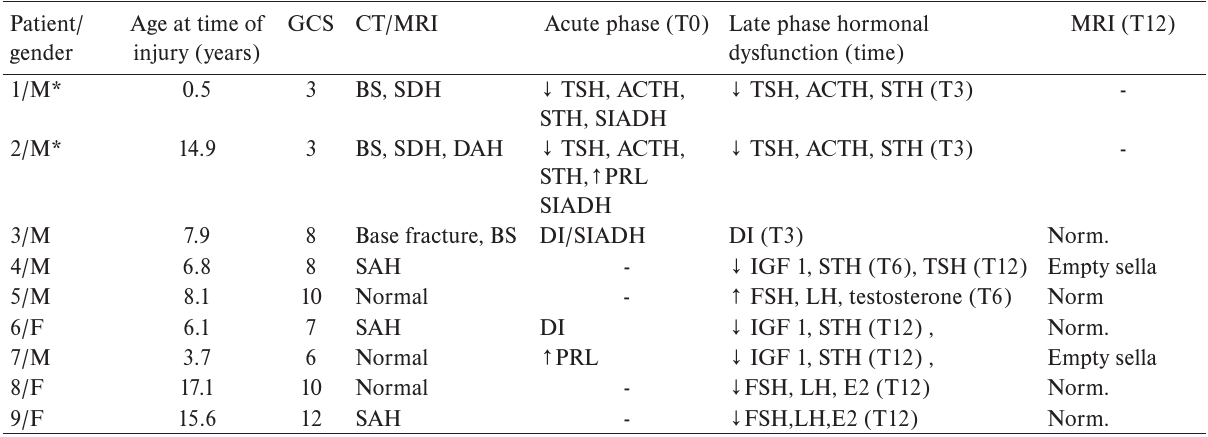
Table 3. Patients with confirmed hormonal